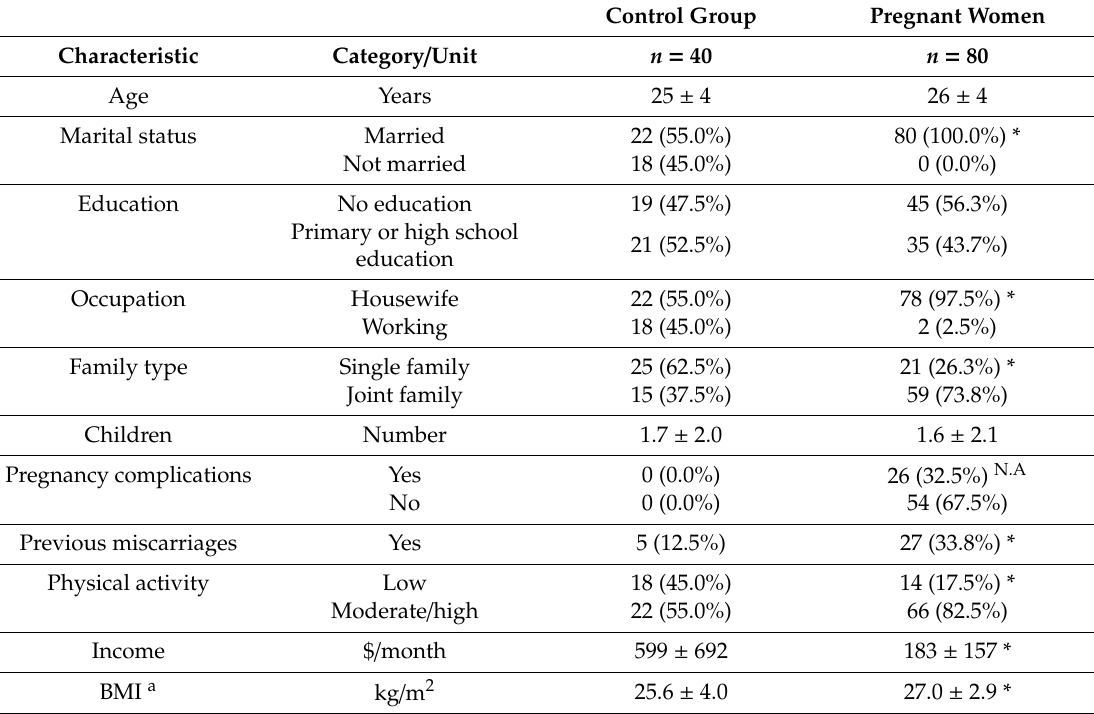
Table 1. Characteristics of study participants (mean ± SD or n (%)). Control Group Pregnant